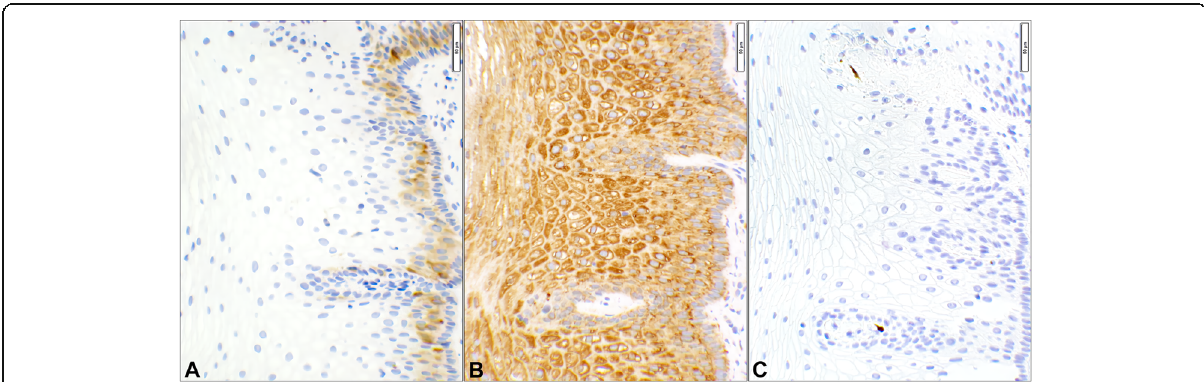
Fig. 2 HSP27 false positivity in benign squamous epithelium. The three photomicrographs are obtained from a case of benign ectocervical tissue (Case #3, Supplemental Table 1). A Stathmin-1 shows weak positivity only in the basal and parabasal layers which is considered as negative. B